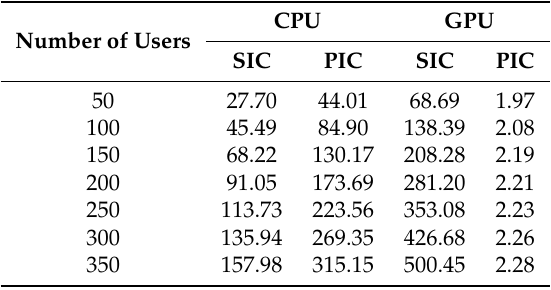
Table 1. Comparison of the computational times of SIC and PIC in ms with an FFT size of 2048.